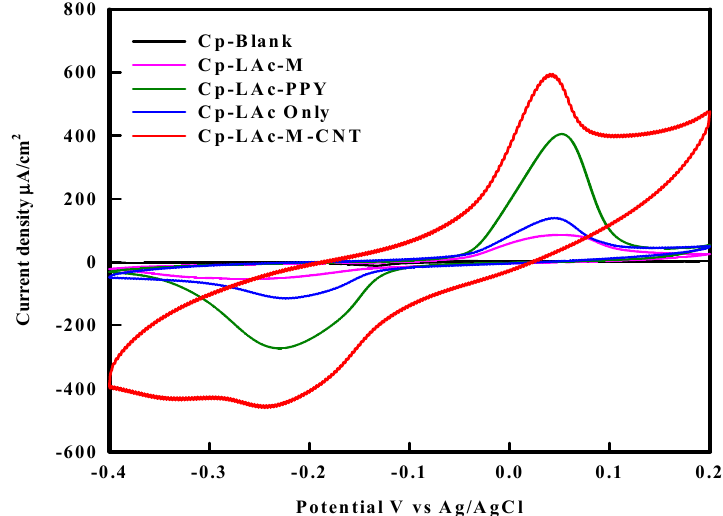
Figure 7. Voltammograms of the hydrophilic biocathode electrode under 0.1 M PBS, pH 7, 37 °C, and O 2 saturation.